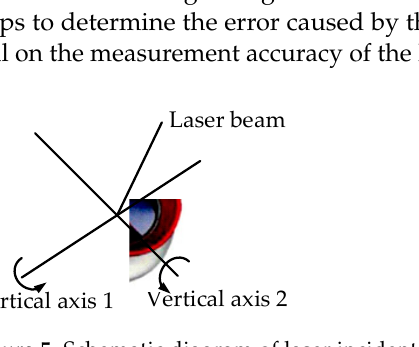
Figure 5. Schematic diagram of laser incident angle error calibration.